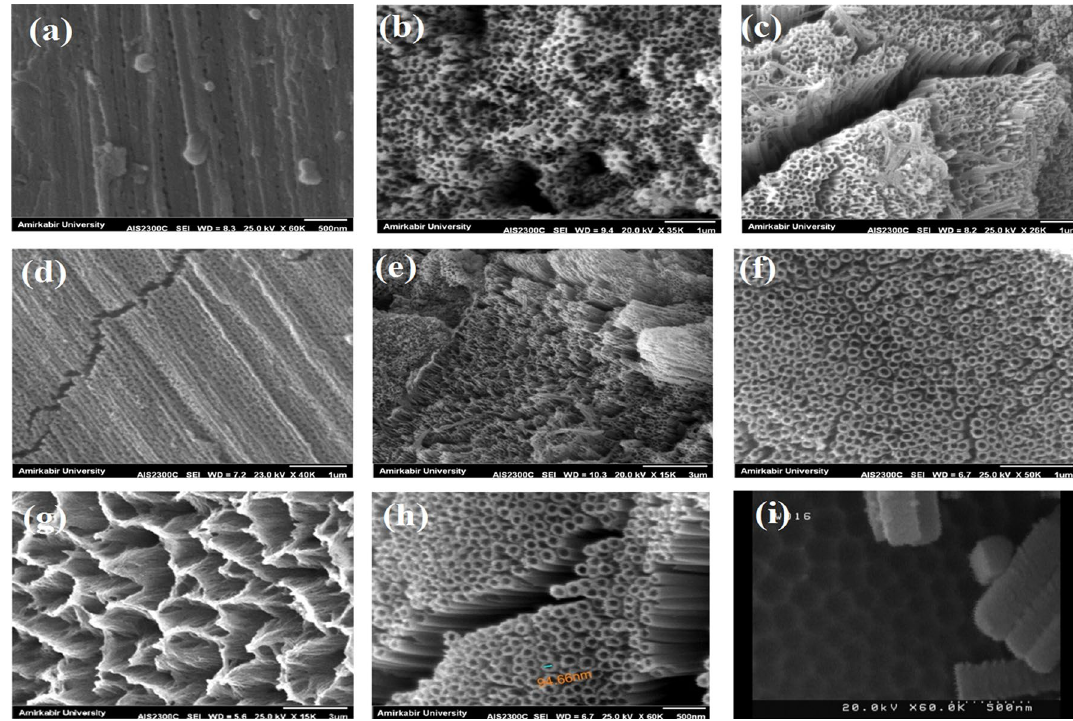
Figure 1. SEM images of samples after anodizing process with different voltages and times (a) 45 V for 1.5 h, (b) 60 V for 1.5 h, (c) 70 V for 1.5 h, (d) 45 V for 3 h, (e) 60 V for 3 h, (f) 70 V for 3 h, (g) 90 V for 3, (h) opened top and (i) closed bottom of TON array constructed by anodizing process with voltage of 70 V and 3